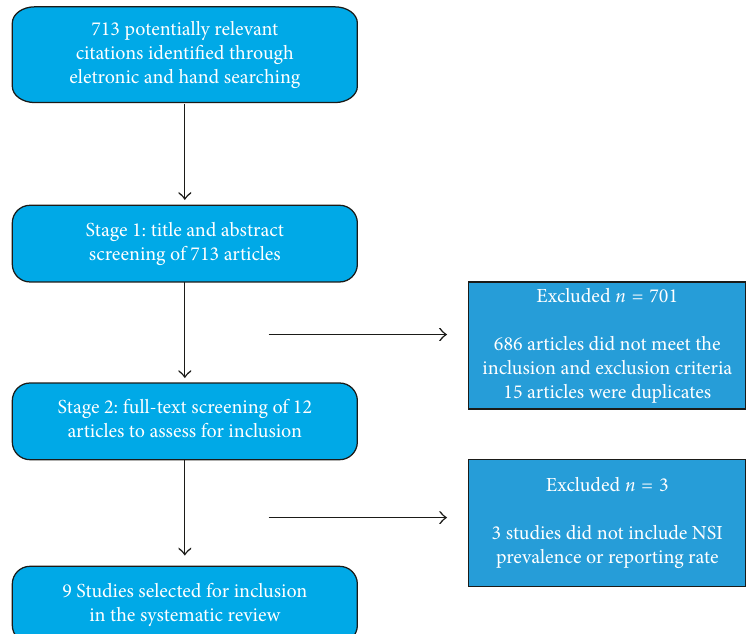
Figure 1: Flowchart of search